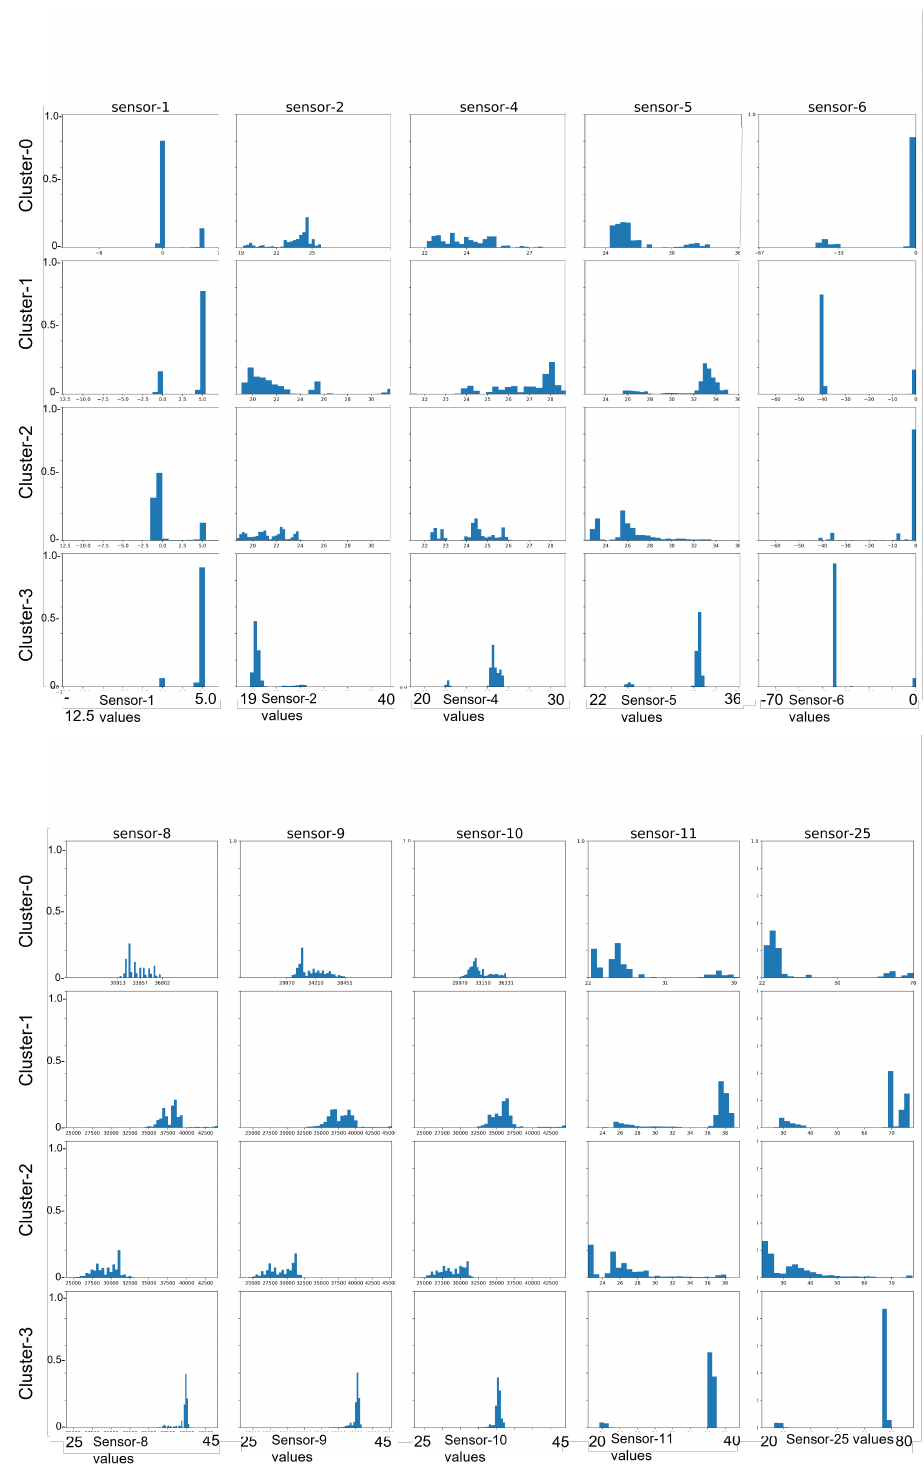
Figure 9. Class panel graph for selected